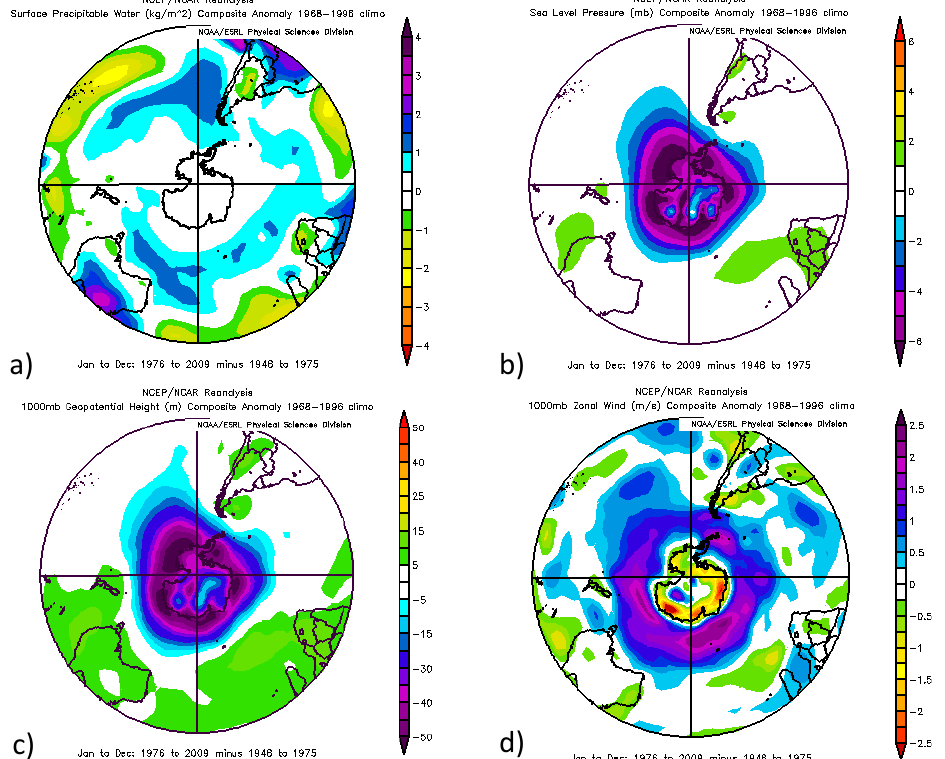
Figure 2. Differences in (a) annual surface precipitable water, (b) sea level pressure, (c) geopotential height and (d) zonal wind